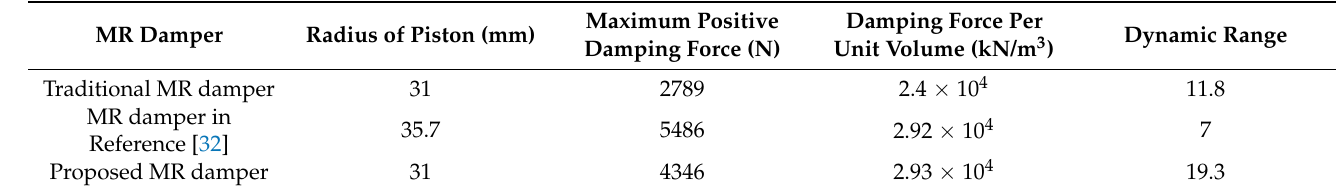
Table 2. Comparison of the damping force per unit volume of the proposed MR damper with other MR